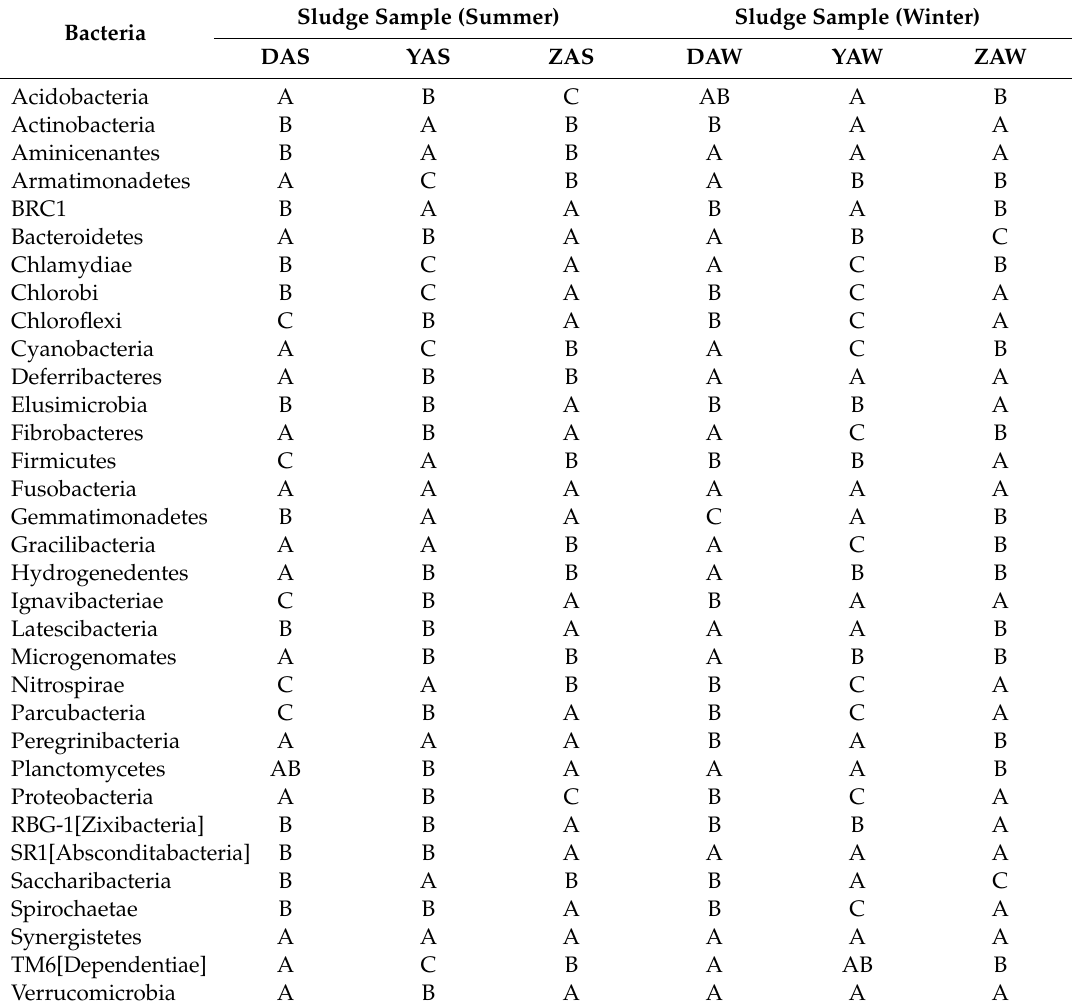
Table 3. Multiple mean comparison of bacterial abundance at the phylum level (significance level of